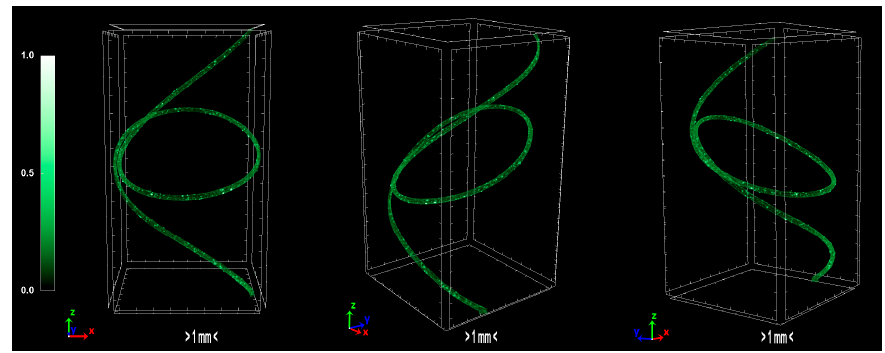
Figure 10. Micro-CT images of the two-stage sulfonated HDPE/SKL (90:10) fibers.